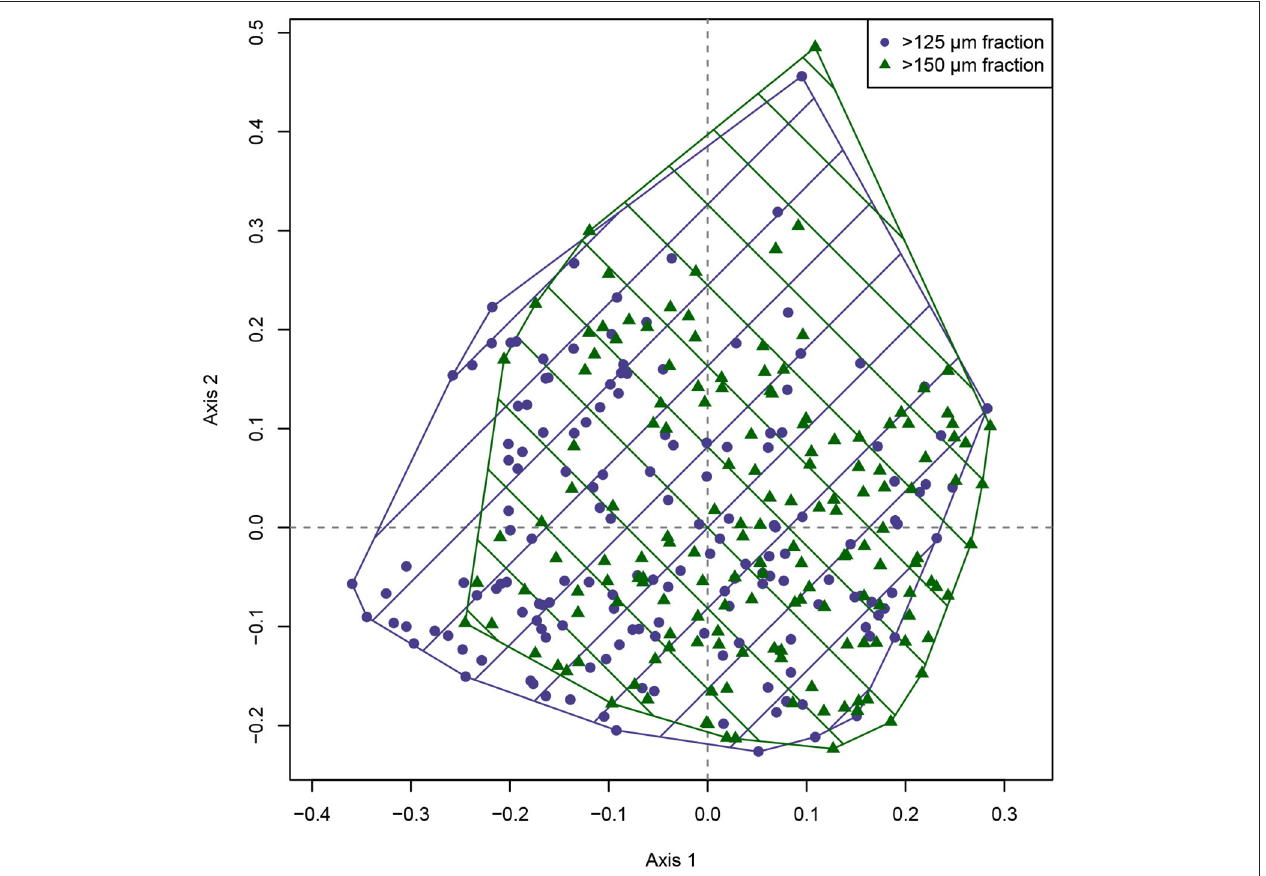
FIGURE 3 | Metric multidimensional scaling of the benthic foraminiferal assemblages from the >125 and >150µm size fraction from the Pefka E section. The two different size fractions are indicated by convex hulls in different colors and crosshatching. The area of overlap between both size fractions (indicated by intersecting crosshatching) is rather large, but a considerable offset along the first ordination axis is